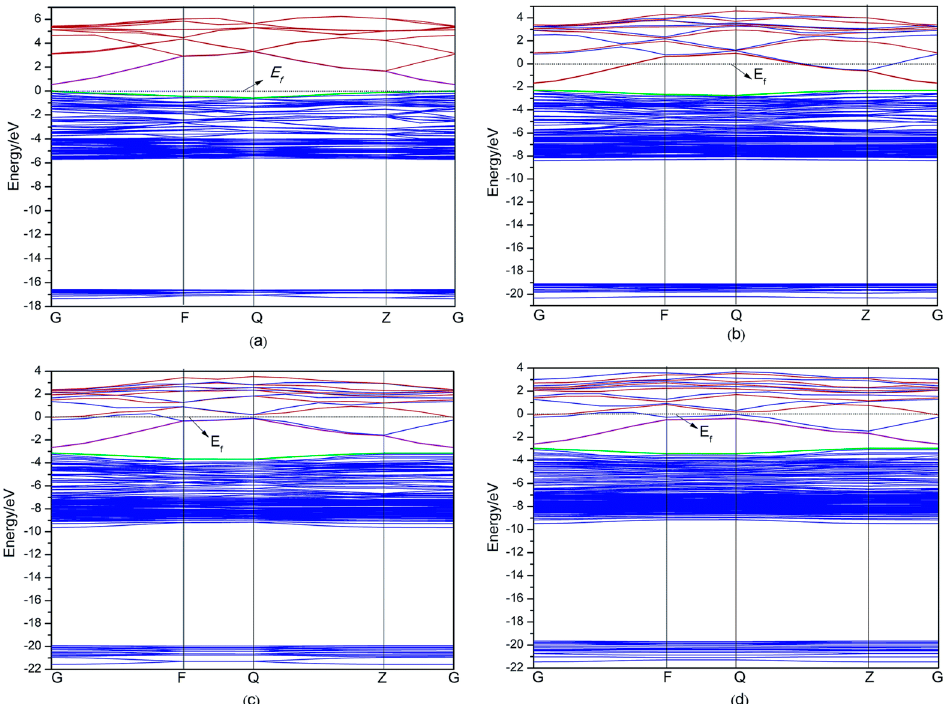
Figure 1. Band structures of Al x Zn 1 − x O with various amounts of doped Al: ( a ) x = 0, ( b ) x = 0.0625, ( c ) x = 0.125, ( d ) x = 0.1875. Reproduced with permission from ref. [54].